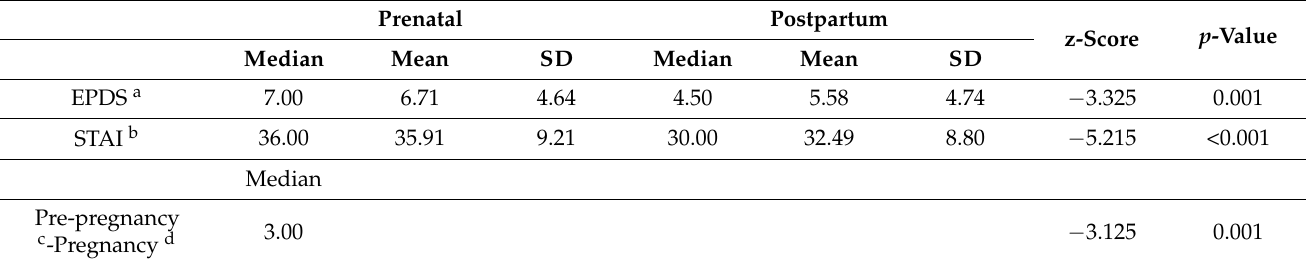
Table 2. Results from the Wilcoxon Signed Rank Test Regarding the Pretest-Posttest of Depressive Scores, Anxiety Scores, and SRH. Prenatal Postpartum